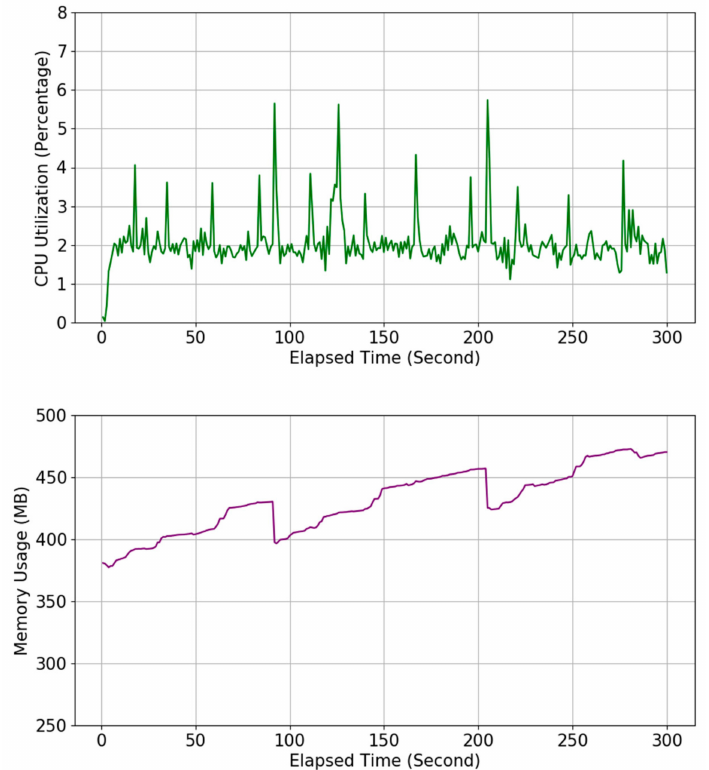
Figure 12. CPU utilization and memory usage of the VS Code with Live Share in a five-minute duration of a real-time collaboration